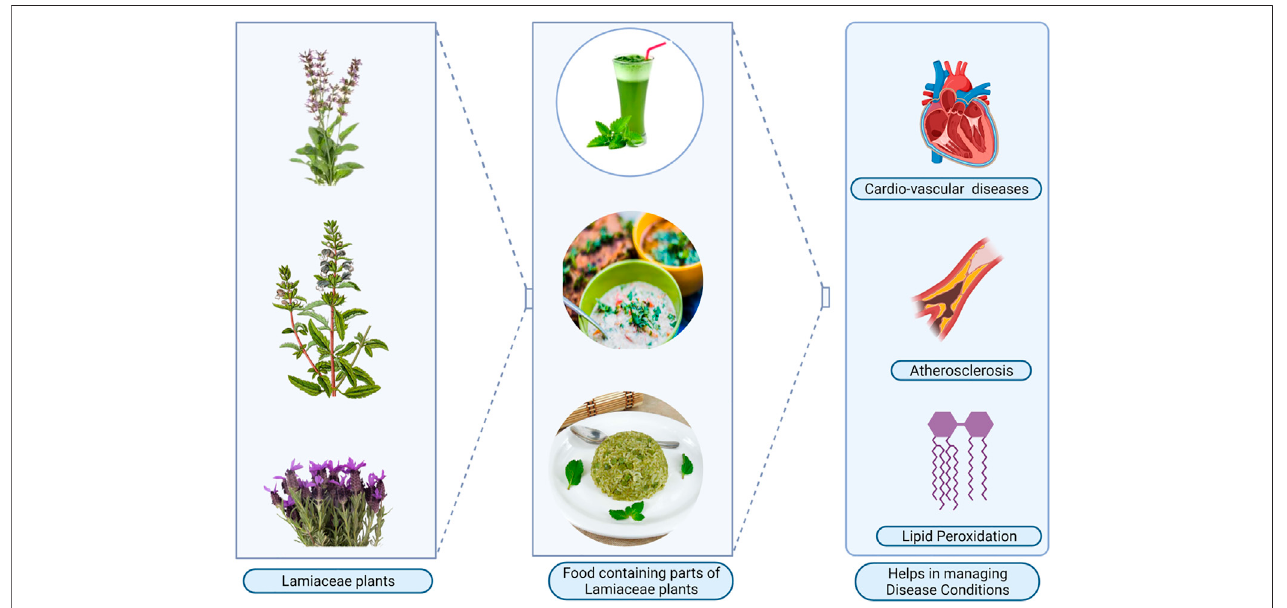
FIGURE 5 | Potential exploration of Lamiaceae as a cardioprotective functional foods (Figure Made in BioRender.com).